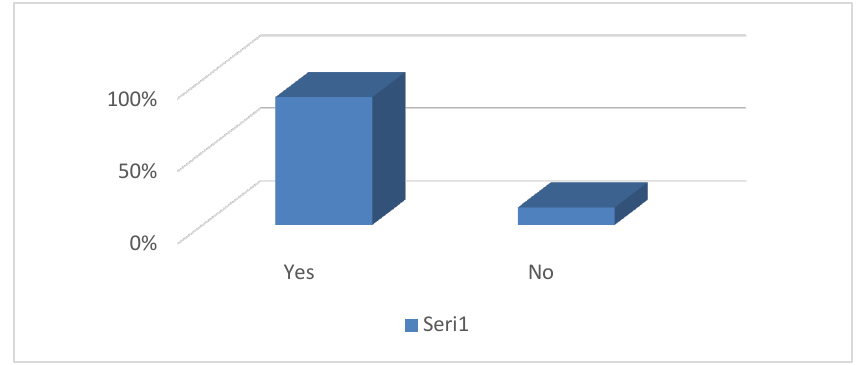
Figure 10: Have you prefer to buy Coca Cola drink after watching the advertisement?